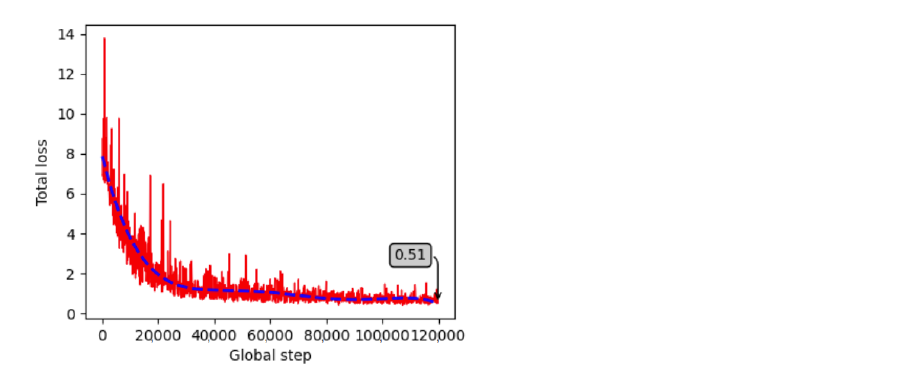
Figure 21. Progress of the training loss for the combined dataset (laboratory and real industrial environment).